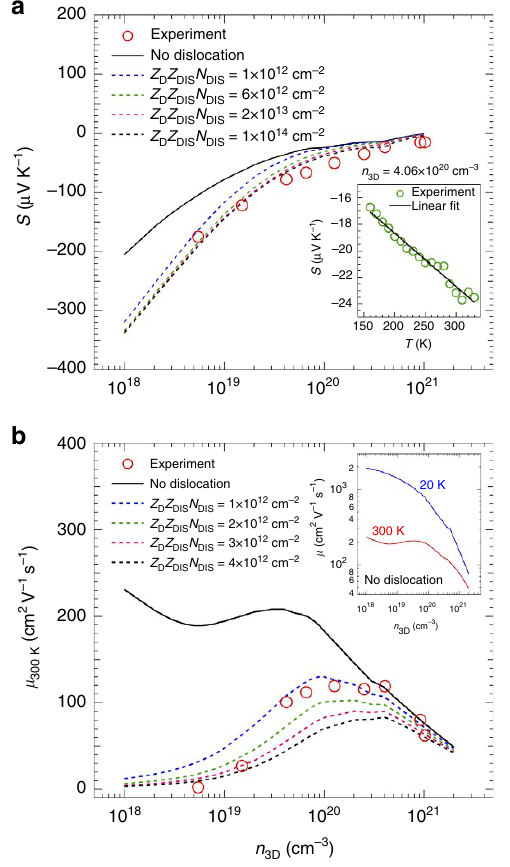
Figure 5 | Comparison of experimental and calculated values of Seebeck coefficient and mobility as a function of carrier concentration with and without dislocations. ( a ) Seebeck coefficients ( S ) of doped BaSnO 3 films at 300K as a function of n 3D . Experimental data are shown as red circles and calculated values are represented using solid line for no dislocation, and using dotted lines for different Z D Z DIS N DIS . Inset shows the T -dependent S for n 3D ¼ 4.06 (cid:3) 10 20 cm (cid:2) 3 , consistent with n-type conduction. ( b ) Room- temperature mobility ( m 300K ) as a function of n 3D . Experimental data are shown in red circles while calculated values are represented with solid (without dislocation) and dotted lines (with varying dislocation density). Inset shows the variation of m at two different temperatures (300K and 20K) for films with no dislocation.